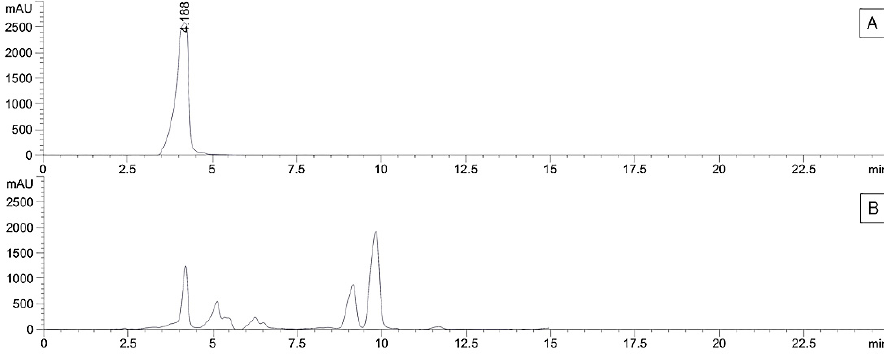
Figure 4. HPLC chromatograms of ( A ) compound 4 and ( B ) crude extract of CC. Table 2. Validation of HPLC analysis of marker compounds of CA ( 1 – 3 ) and CC ( 4 ).